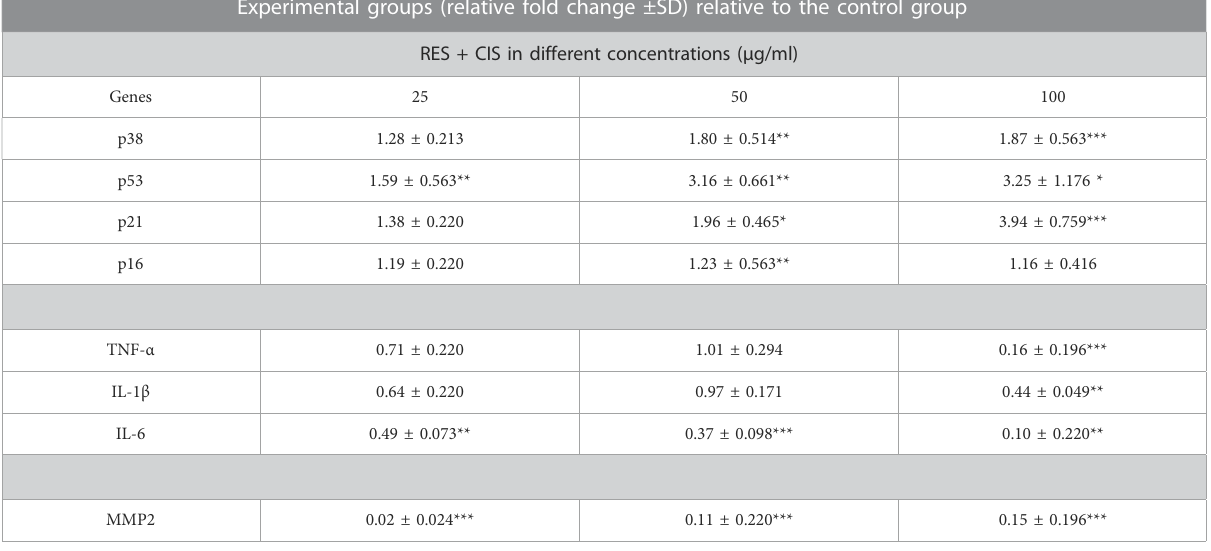
TABLE 1 Effect of resveratrol (RES) and different concentrations of cisplatin (CIS) on p38, p53, p21, p16, TNF- α , IL-1 β , IL-6 and MMP2 cell migration marker expression level. The β -actin gene has been used as the housekeeping gene. Experimental groups (relative fold change ±SD) relative to the control